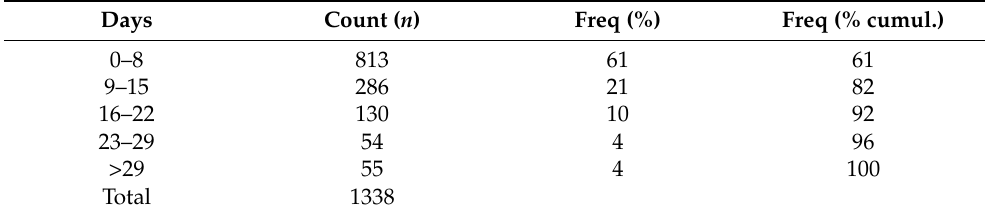
Table 2. Test return frequency from n = 46 intermediate age-related macular degeneration participants with uptake of home monitoring.